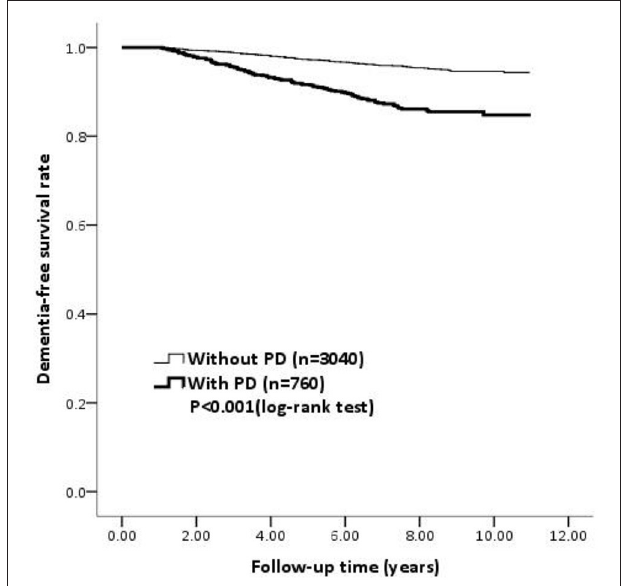
FIGURE 2 | The survival curve determined using the Kaplan-Meier survival analysis for dementia among PD patients and non-PD patients. PD, Parkinson’s